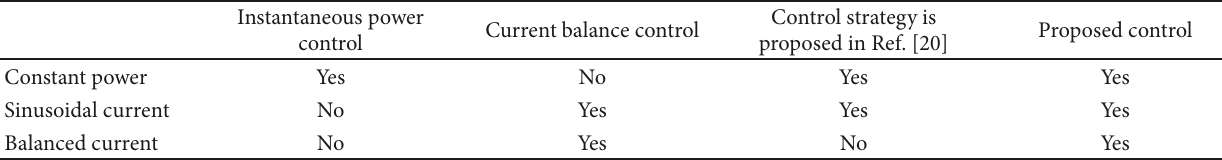
Table 2: Control effect comparison under different control